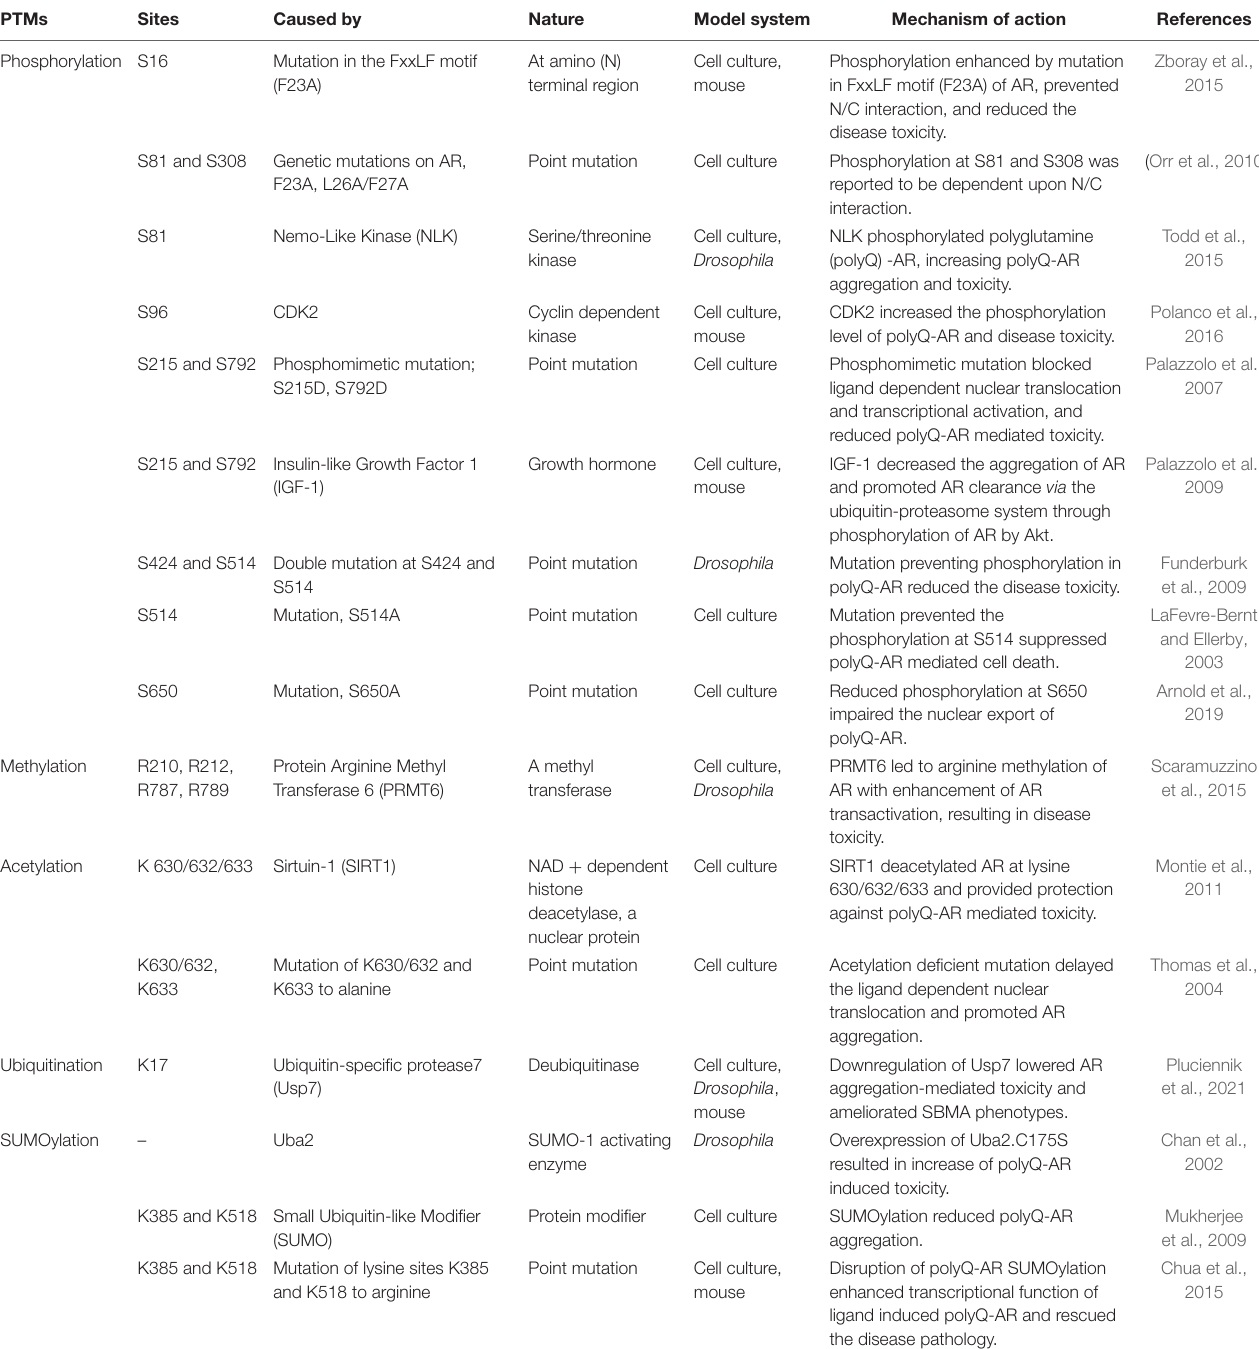
TABLE 1 | Posttranslational modifications (PTM) sites within the Androgen Receptor (AR) that can modulate the spinal and bulbar muscular atrophy (SBMA) pathogenesis. PTMs